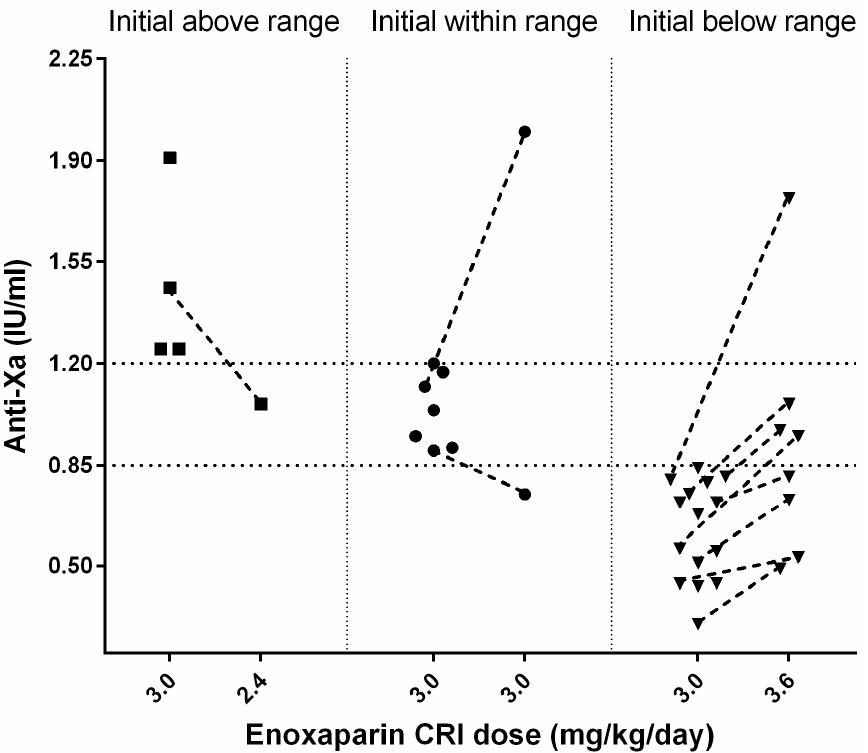
Figure 1. Schematical representation of anti-Xa activity measured in 26 cats with ATE during enoxaparin CRI treatment. The population is divided to initially above (square), within (circle), and below (upside-down triangle) therapeutic anti-Xa range. If available, a following measurement after appropriate dose change is depicted with a dashed line.